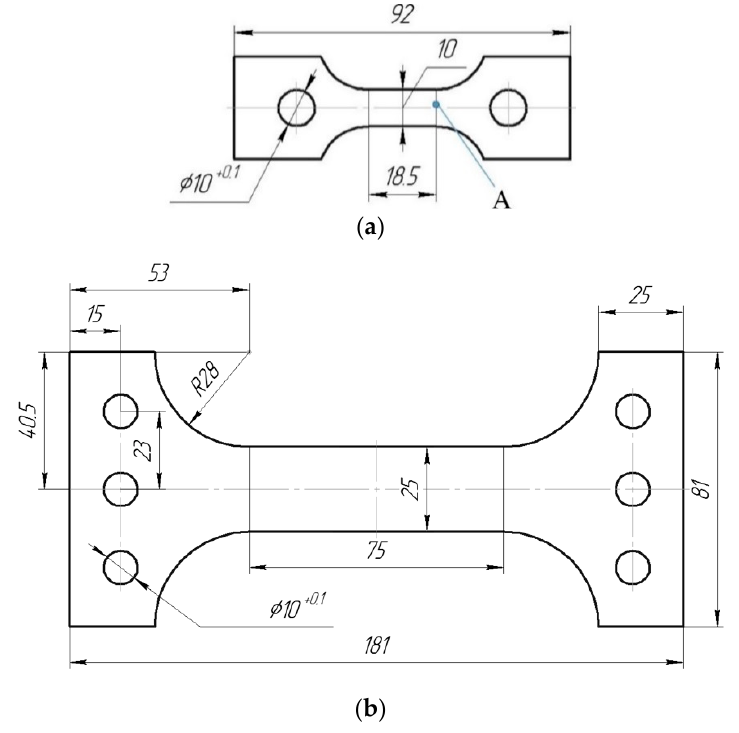
Figure 1. Test specimens: ( a ) Small specimen; ( b ) large specimen.